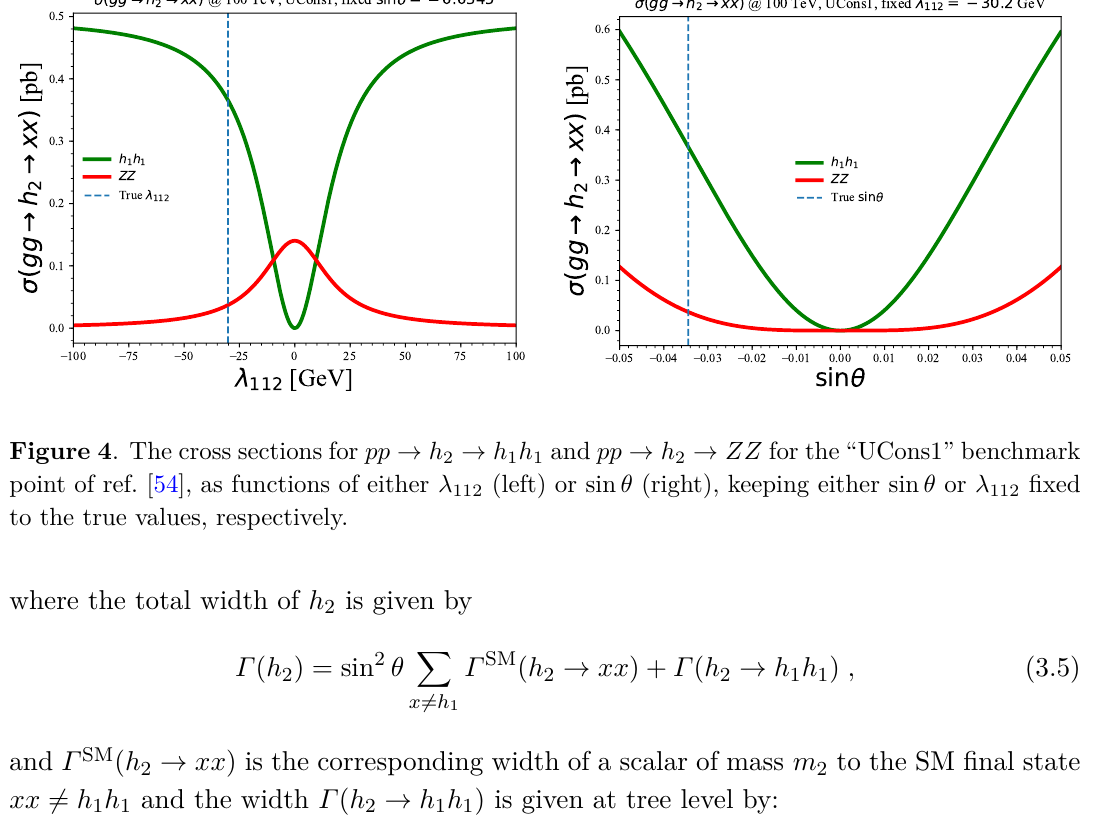
(left) or sin θ (right), keeping either sin θ or λ 112